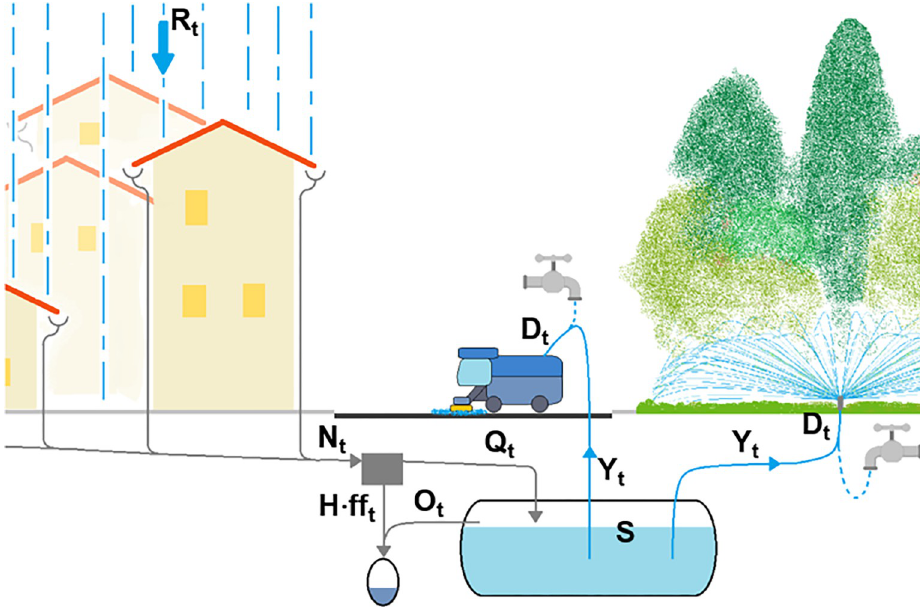
Fig 2. Scheme of a rainwater harvesting system for public use: Green area irrigation and street